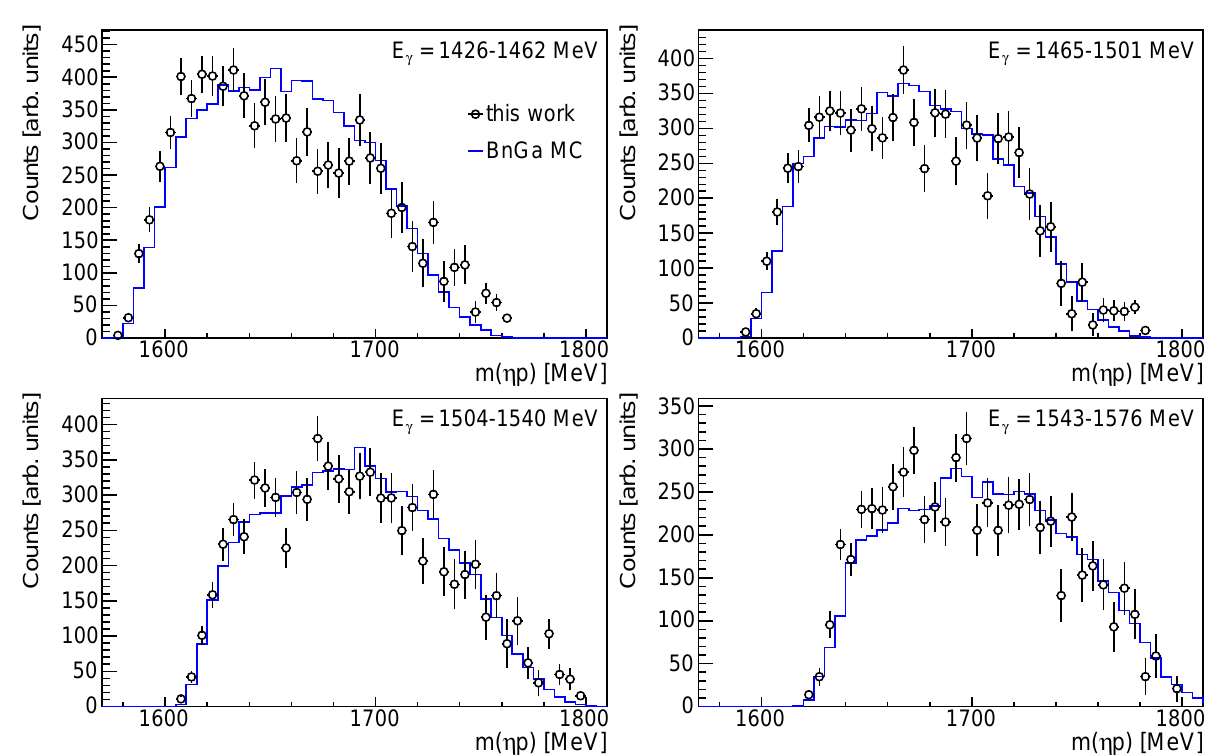
Figure 7. Invariant mass m ( η p ) of γ p → ηπ 0 p for four bins of photon-beam energy with m ( π 0 p ) < 1180 MeV (no acceptance correction). The data (black circles) are compared to a phase-space MC simulation (blue curves, normalized by integral ratio) using event weights from the BnGa partial-wave analysis of [45].